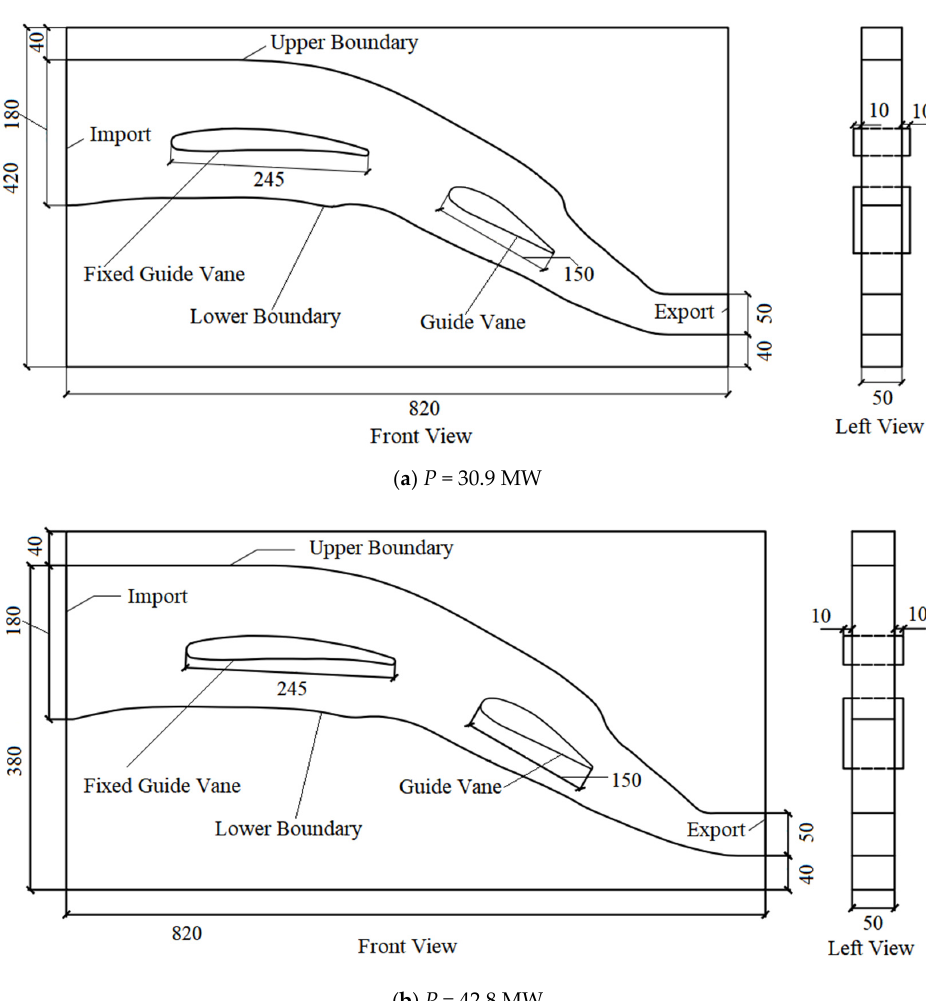
Figure 5. ( a , b ) CAD design drawing of test bench.